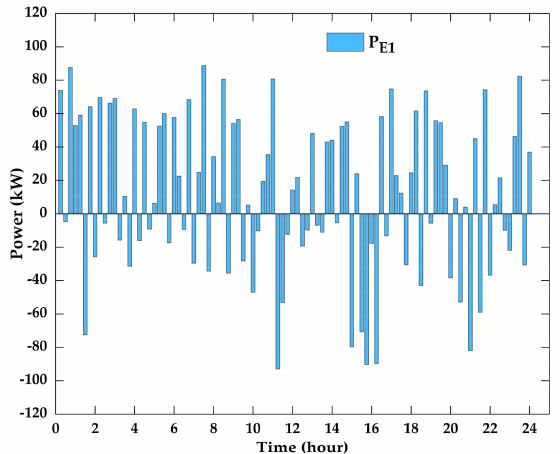
Figure 18. Exchange power of module